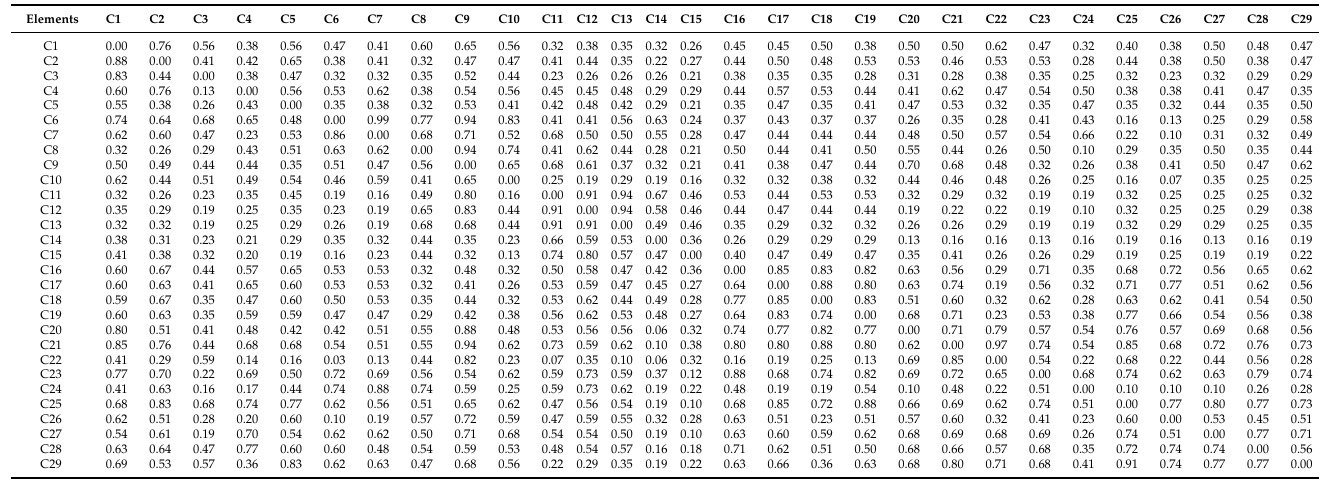
Table 5. The average influence matrix of all experts on elements affecting the MSOs.